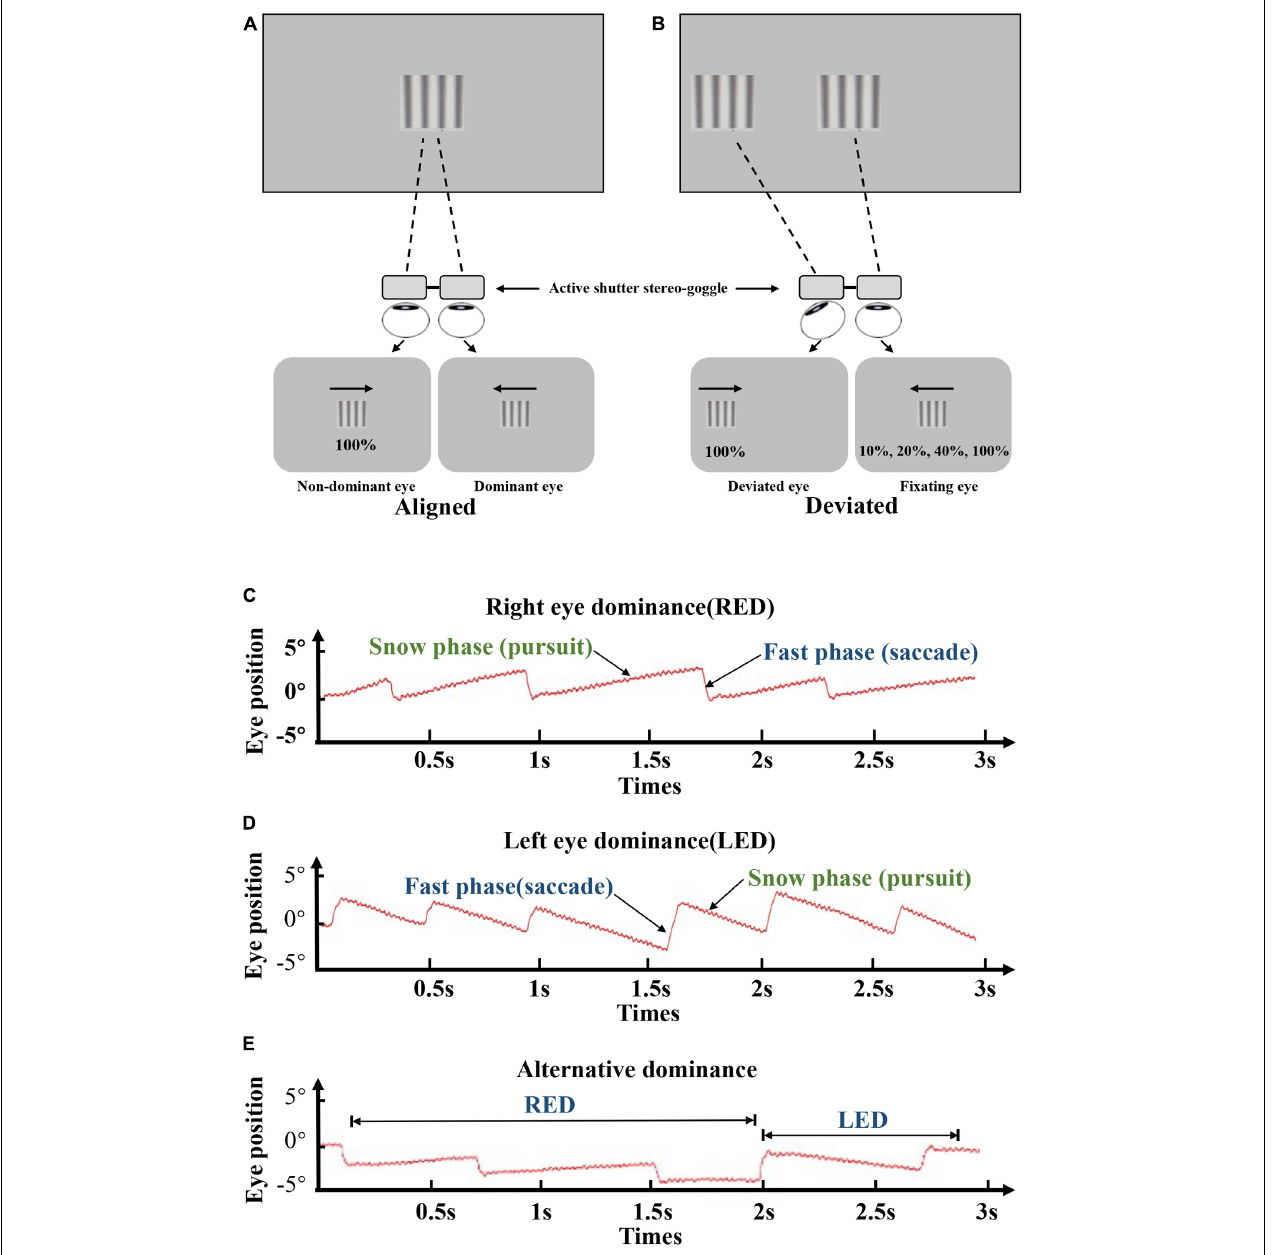
FIGURE 1 | Visual suppression by dOKN test. (A,B) All subjects were instructed to track two opposite drifting gratings at the distance of 57 cm, under the dichoptic state by using 3D VISION LCD shutter glasses. Both eyes were stimulated with different visual inputs: the non-dominant/deviated eyes were treated with high contrast grating (100%), and the dominant eyes were treated with varied contrast grating (10, 20, 40, and 100%). For healthy controls, interocular suppression was induced by placing neutral density (ND) filters (0, 0.9, or 1.5 ND) in front of their non-dominant eye. All stimulations lasted for 3 s followed by a 2-s break and were repeated 15 times. (C–E) Red lines represent the ocular moving path during OKN stimulation. The moving pattern of the slow phase suggests the dominant eye. Right eye dominance (C) , left eye dominance (D) , and alternating dominance (E)